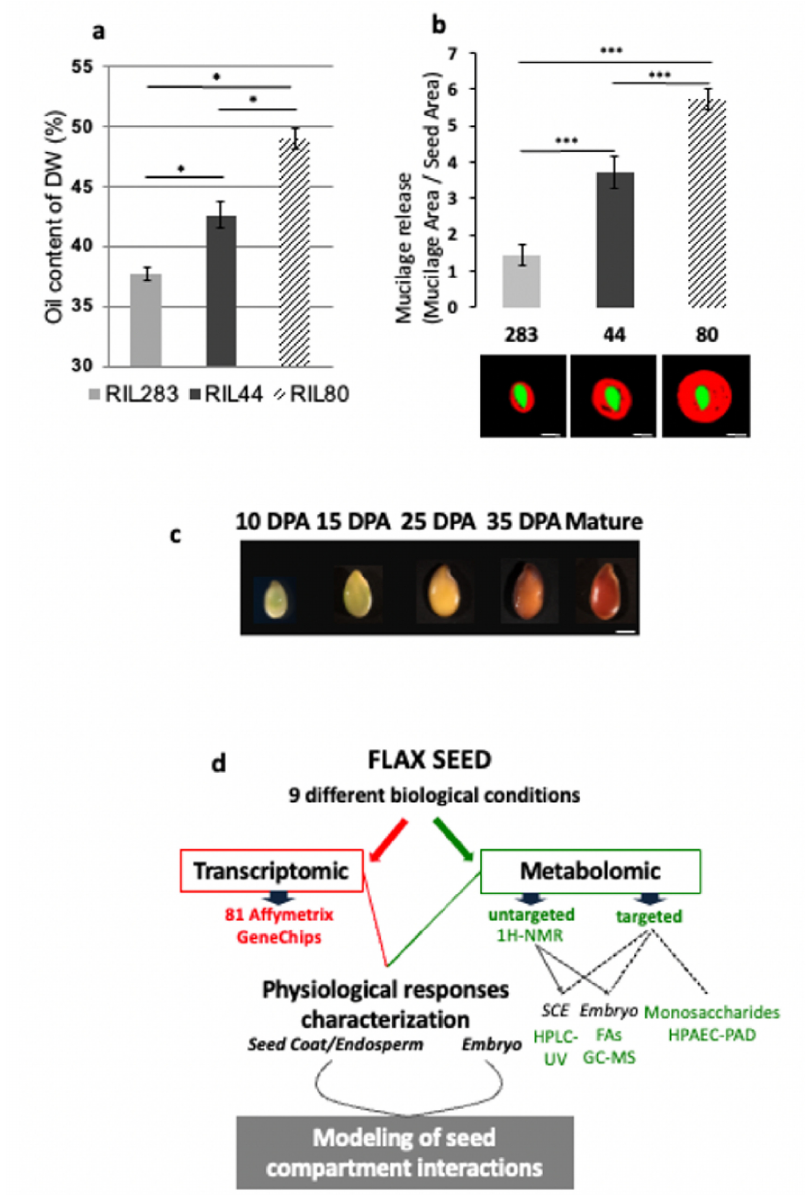
Figure 1. Phenotypic characterization of the 3 selected RILs and experimental strategy